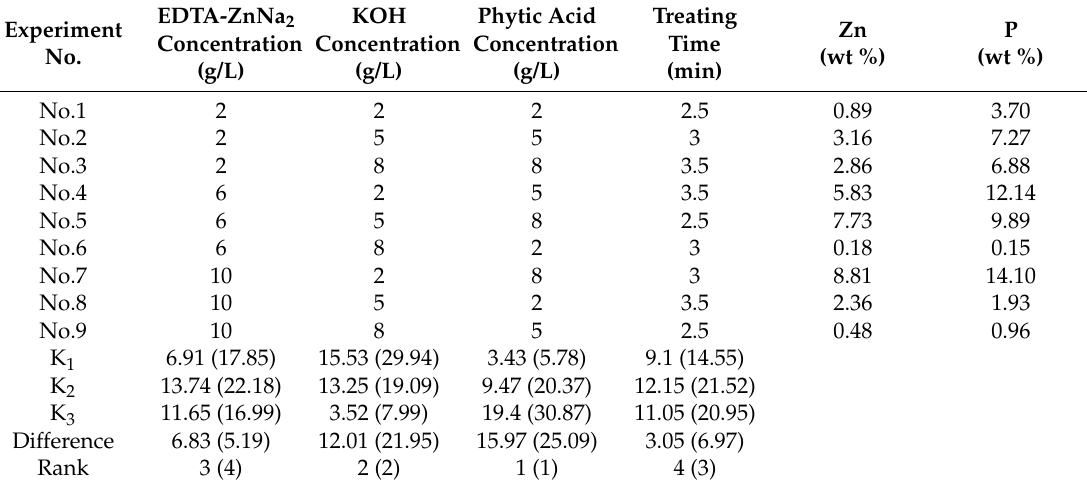
Table 2. The orthogonal experimental array and experimental